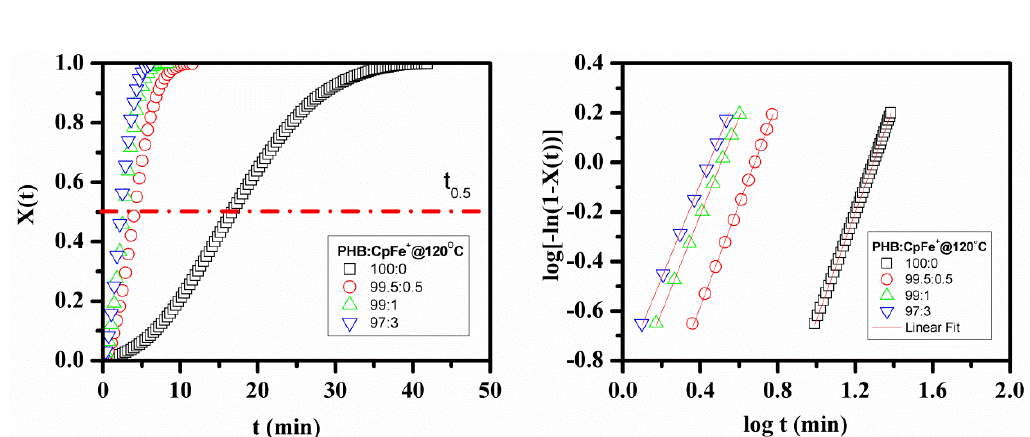
Figure 6. Relative crystallinity ( X ( t )) ( right ) and its corresponding typical Avrami plot ( left ) in the isothermal crystallization process for the pure PHB and PHB/ CpFe + nanocomposites.